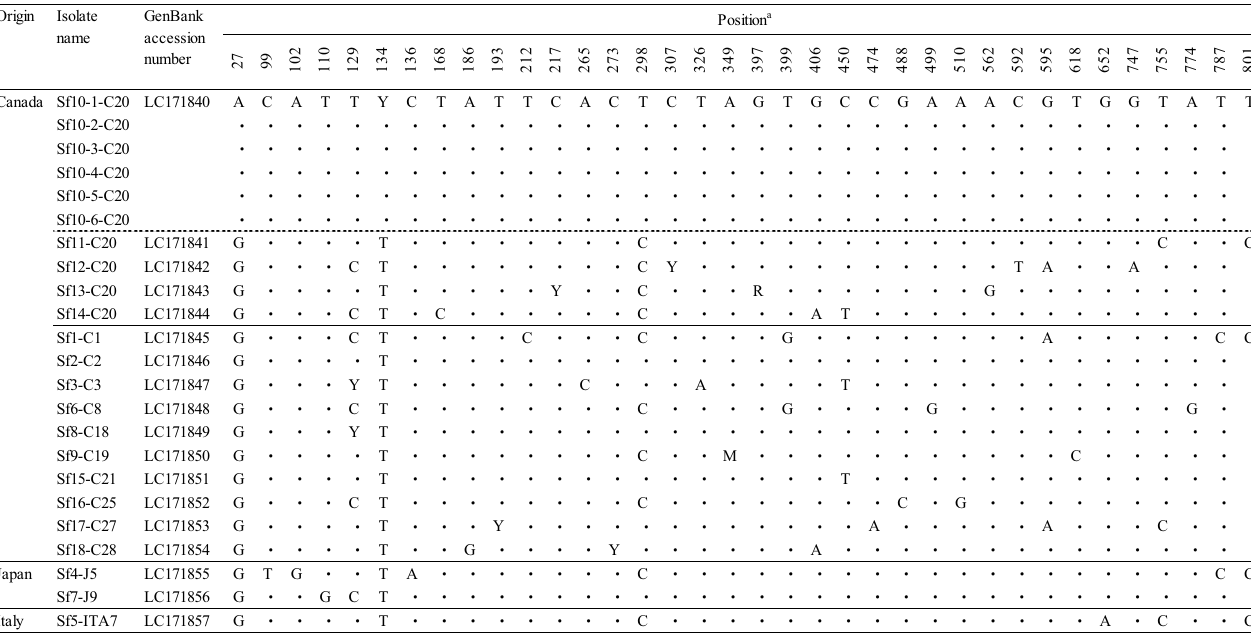
Dots indicate matches to the Sf10-1-C20 sequence. a Nucleotide position from the 5 ’ end of LC171840.